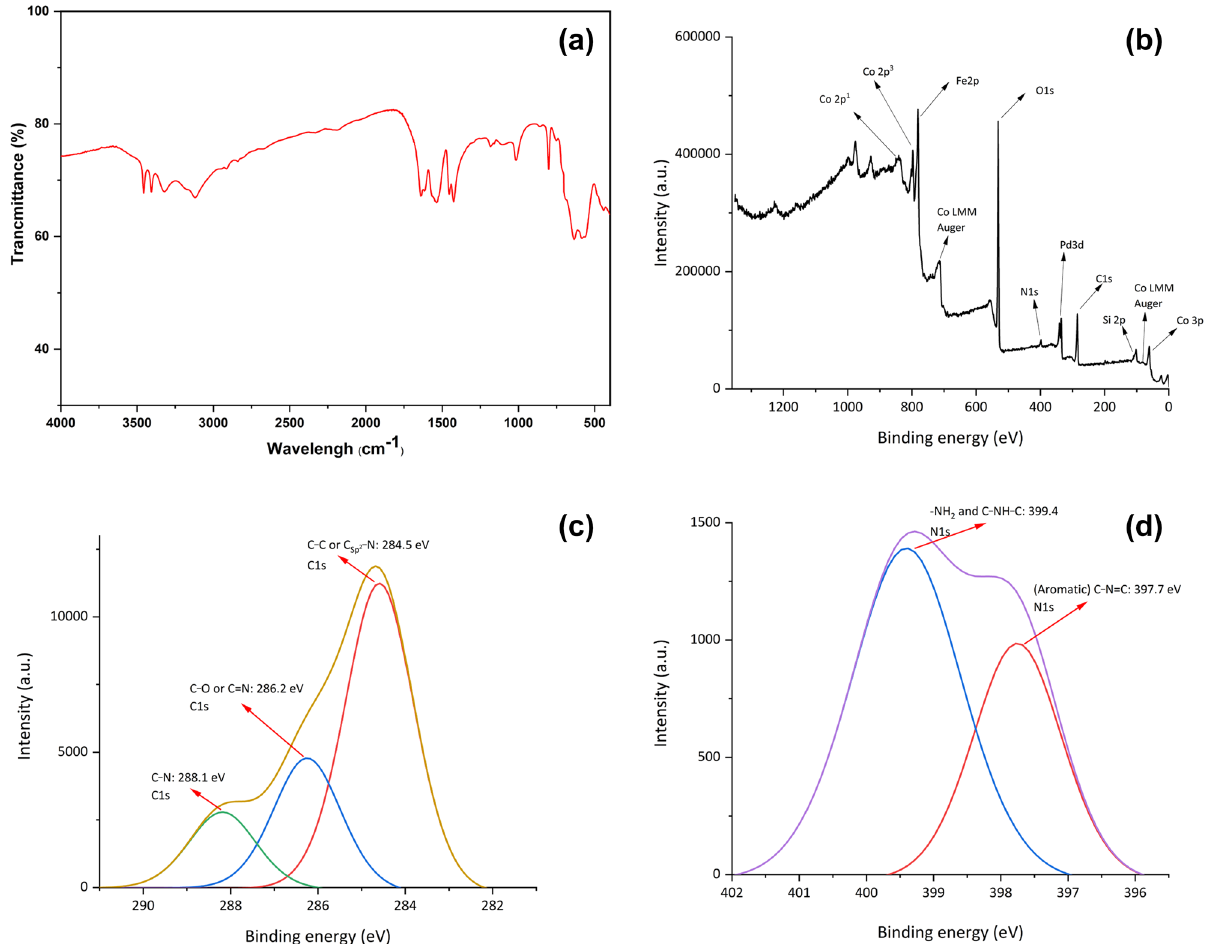
Figure 10. ( a ) FT-IR spectrum, ( b ) XPS pattern, ( c ) C 1s, ( d ) N 1s, ( e ) Pd 3d, ( f ) Co 2p and ( g , h ) TEM images of recycled γ-Fe 2 O 3 @MBD/Pd-Co after ten reaction